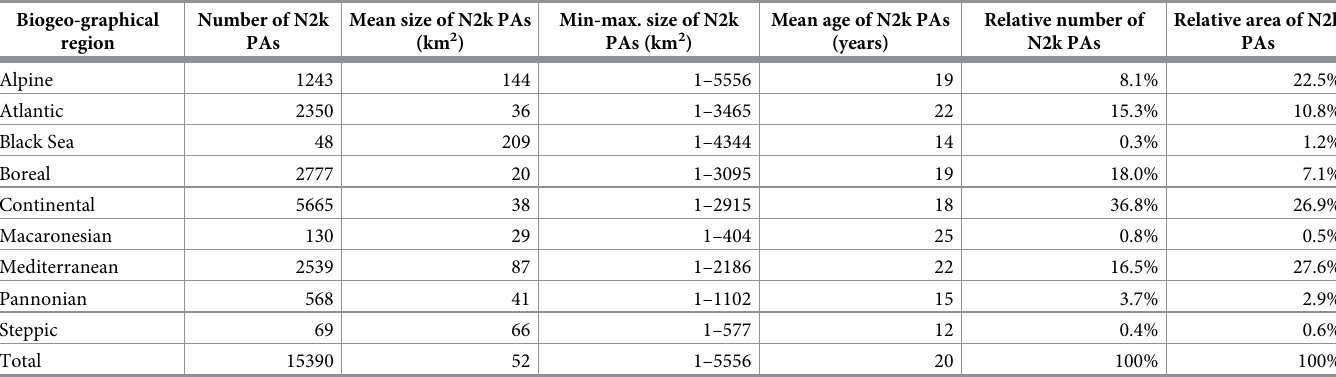
Table 1. The N2k network across biogeographical regions of the EU. Biogeo-graphical